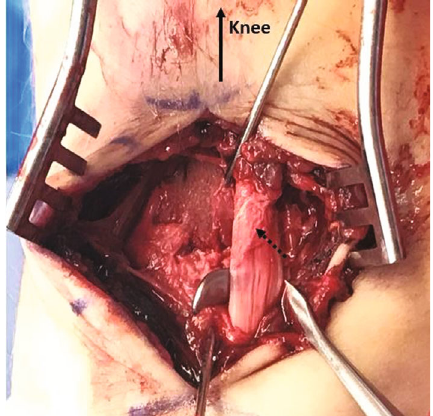
Figure 4: Mildly frayed tibialis posterior tendon (dashed arrow) repositioned and fracture reduction temporarily fi xed by K-wire fi xation.